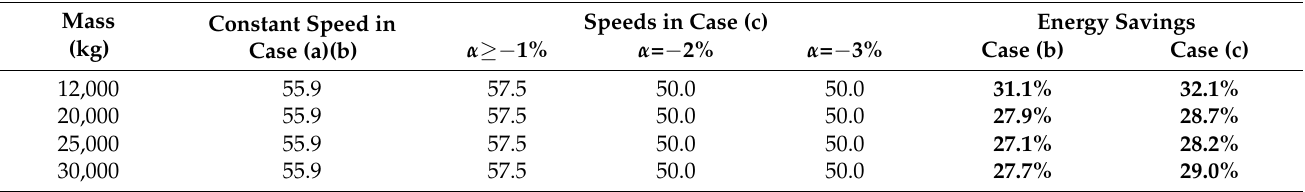
Table 5. Speeds (mph) and relative energy savings of four types of trucks in three cases with regenerative braking.